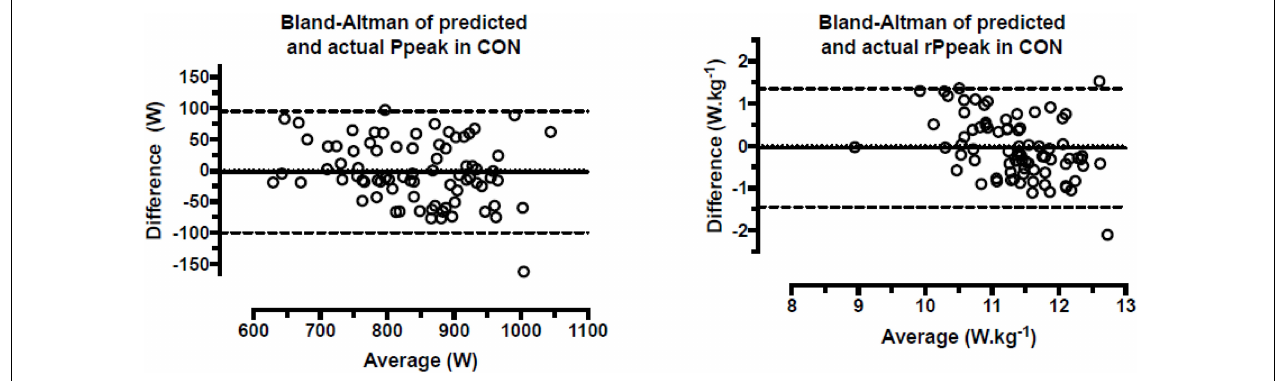
FIGURE 2 | Bland–Altman plots of predicted and actual peak power of the control group in the Wingate anaerobic test. P peak = absolute peak power; rP peak = relative peak power; CON = control group; Difference = predicted – actual; Average = (predicted + actual)/2; dashed lines represent 95% confidence intervals of